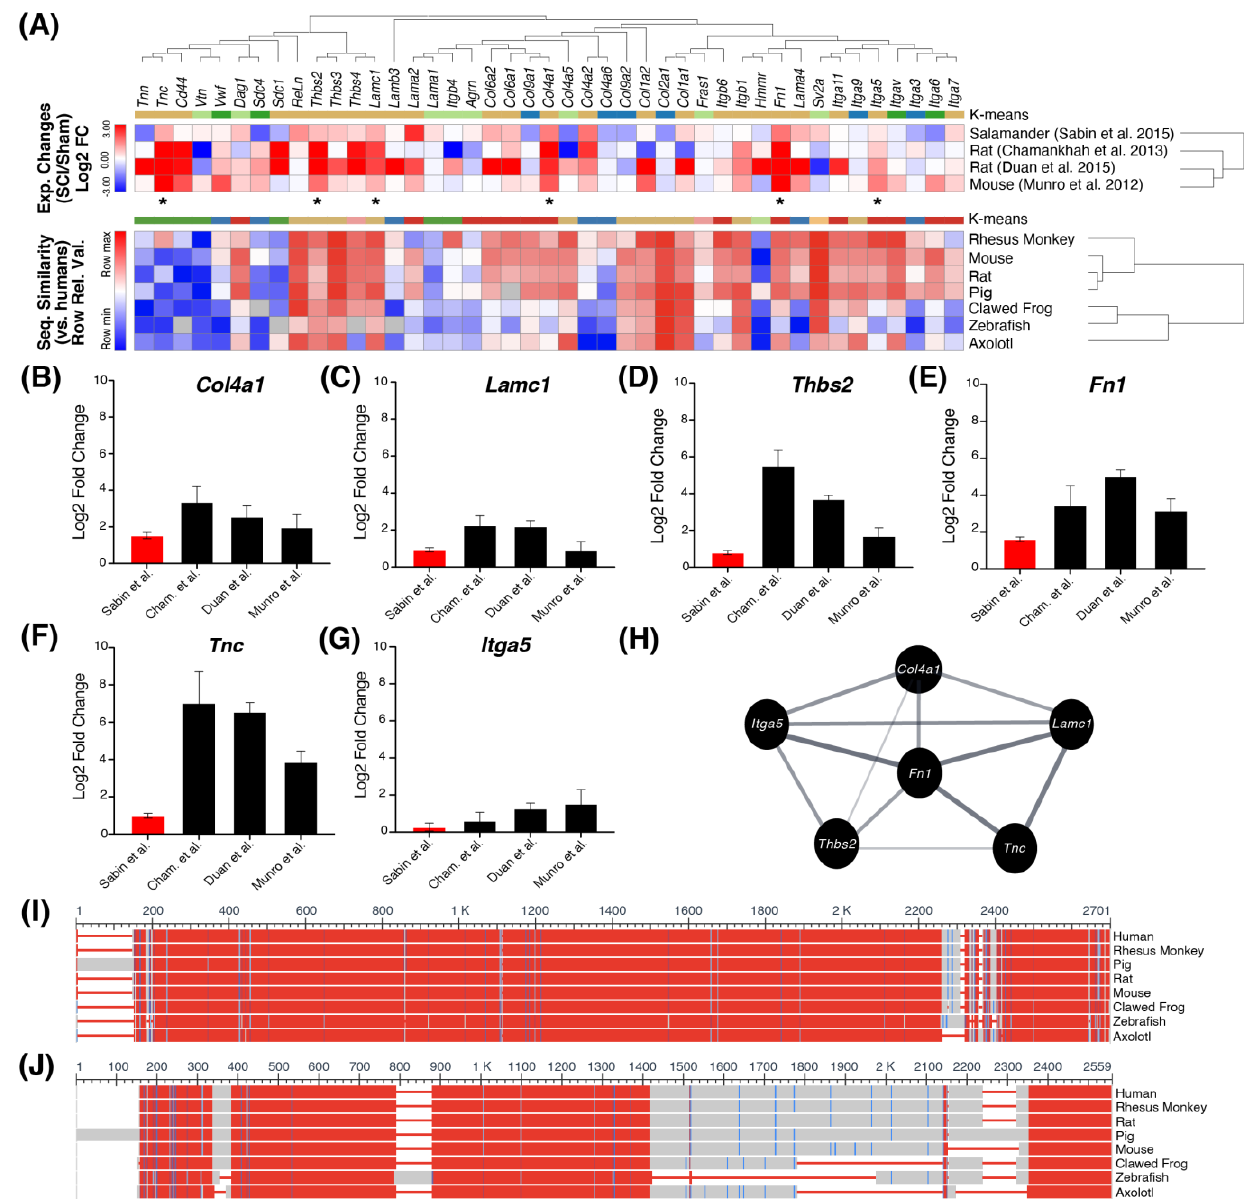
Figure 3. ECM-receptor interaction pathway (KEGG ID: mmu04512) contained the greatest number of orthologs with consistent direction of expression in all four studies ( p -adj. = 0.003, ES score = 3.51). ( A ) Orthologs that were expressed in all four studies were included in the top heatmap, and Mus musculus was used as the reference organism. Asterisks (*) indicate genes that were significantly differentially expressed after SCI ( p -adj. ≤ 0.05) in all four studies. Based on cosine similarity, the species were hierarchically clustered, and the genes were classified via K-Means into four groups. Additionally, the genes were ordered according to evolutionary distances as determined by the phylogenetic tree, which was constructed via the neighbor-joining method in MEGA X. The bottom heatmap compares the relative amino acid percent sequence identity of each gene across the species commonly used in SCI studies. K-means based on cosine similarity was used to classify the bottom heatmap into six groups. ( B – G ) The selected bar graphs depict the log2FC values for orthologs that were significantly differentially expressed after SCI in all four studies ( p -adj. ≤ 0.05), including in salamanders (depicted in red). Data represented in Log2FC ± 95% confidence interval. ( H ) The protein-protein interaction for the six SCI-induced DEG with consistent direction of expression. ( I , J ) COBALT multiple sequence alignment for fibronectin 1 and tenascin c proteins, respectively. Conserved amino acid sequences are shown based on the relative entropy threshold of the residue. Red indicates high conservation and blue indicates lower conservation, whereas grey indicates amino acids in positions that are not conserved. Only regions with no gaps are